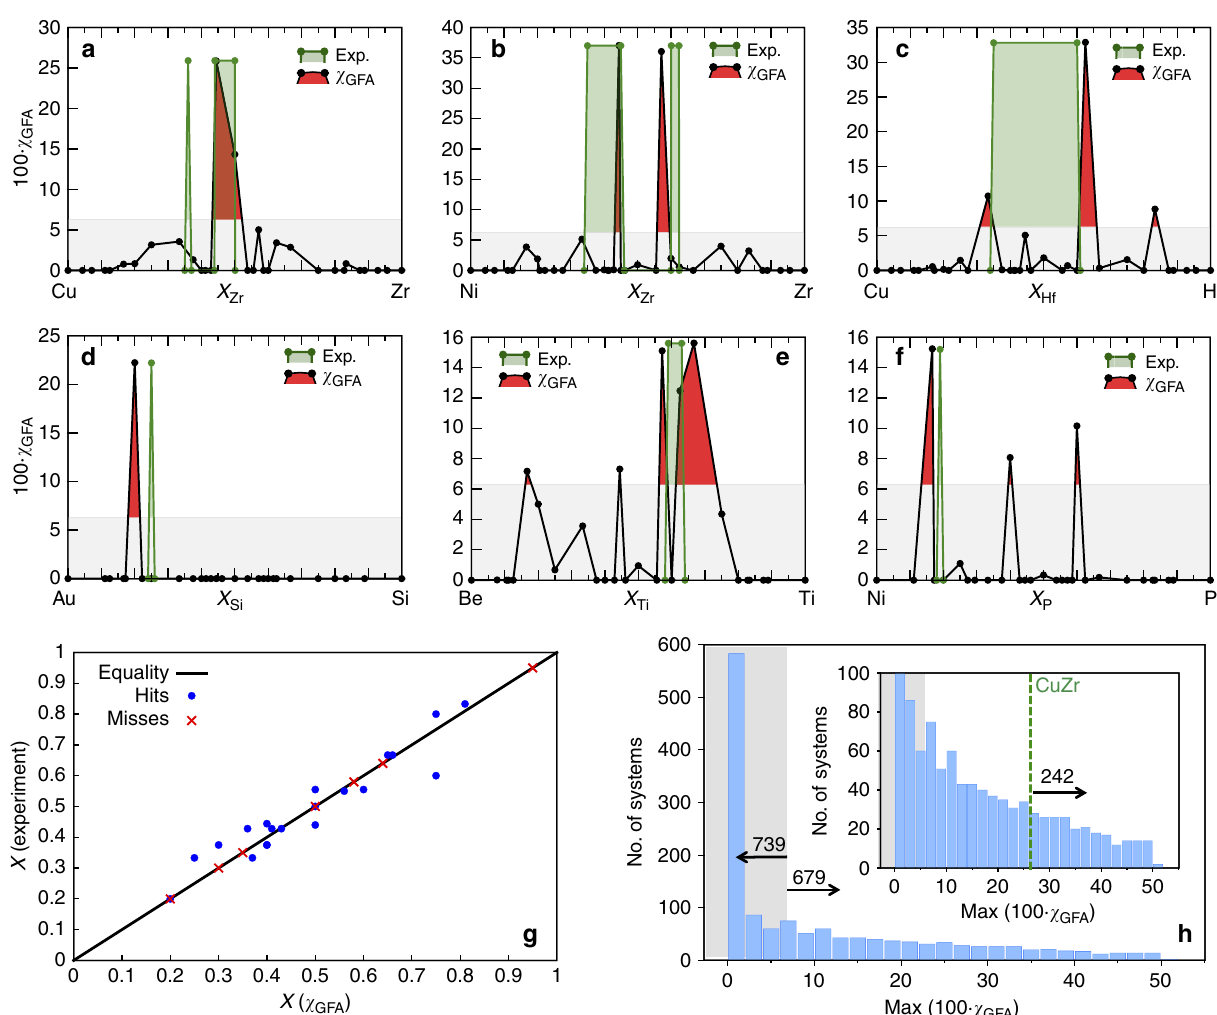
Figure 5 | GFA descriptor spectra for different alloys. Predictions are shown in black line/solid red fill, experimentally reported compositions are shown in green line/transparent green fill and the area under the threshold is shown in grey. ( a ) CuZr (reported glass formers Cu 50 Zr 50 , Cu 56 Zr 44 and Cu 64 Zr 36 (refs 42,79)); ( b ) NiZr (reported glass formers Ni 1 (cid:3) x Zr x with 0.35 o x o 0.45 and 0.60 o x o 0.63 (ref. 46)); ( c ) CuHf (reported glass former Cu 1 (cid:3) x Hf x with 0.35 o x o 0.60 (ref. 65)); ( d ) AuSi (reported glass former Au 75 Si 25 (ref. 66)); ( e ) BeTi (reported glass former Be 1 (cid:3) x Ti x with 0.59 o x o 0.63 (ref. 67)); ( f ) NiP (reported glass former Ni 81 P 19 (ref. 68)). ( g ) Reported versus predicted glass-forming concentrations for the 16 training systems. Missed glass formers are noted as red crosses. ( h ) Statistical distribution of the maximum peak GFA value for 1,418 different binary alloys. Inset shows a close up of the same plot. Area under the threshold is shown in